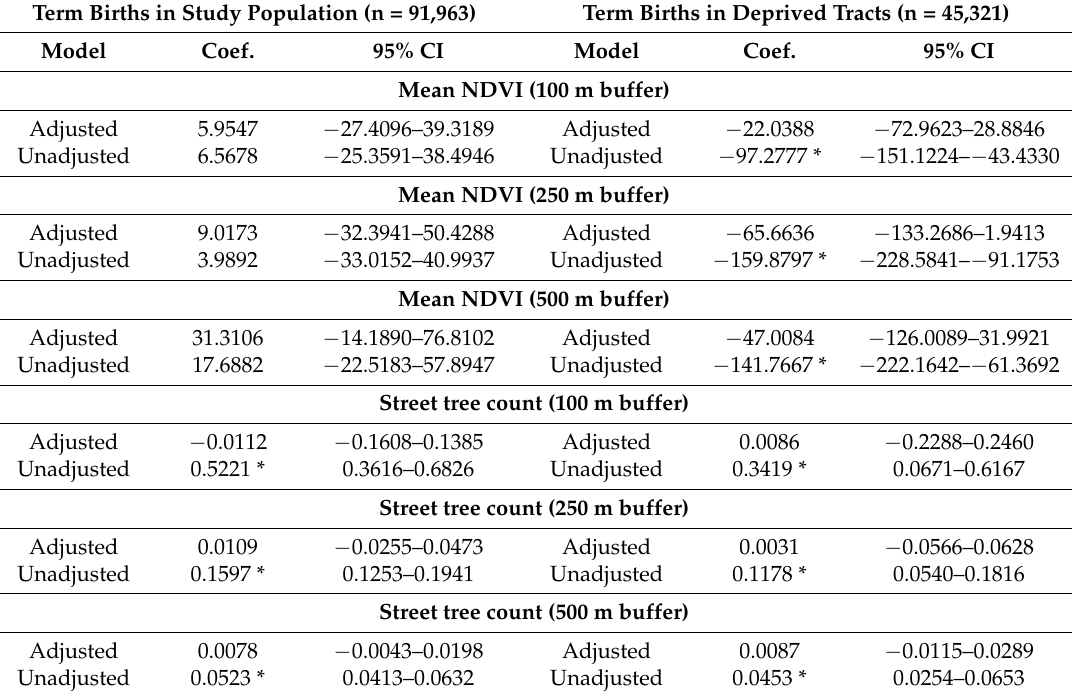
Table 4. Mixed-effects linear regression results for term